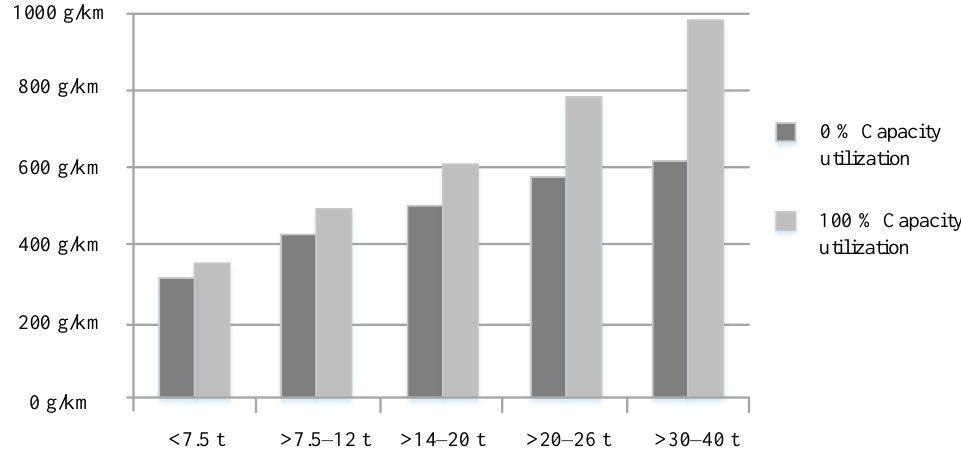
Fig. 2. Emission factors with respect to load factor